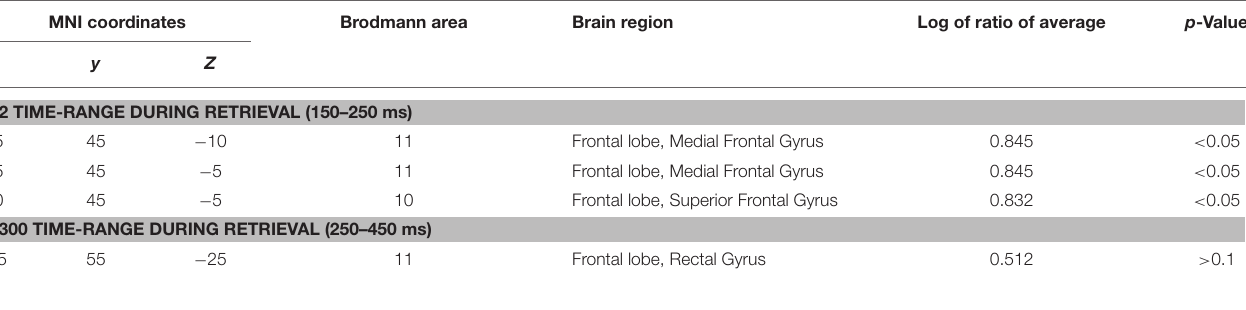
TABLE 4 | Comparison of aMCI and normal control group in sLORETA (voxels showing maximal difference). MNI coordinates Log of ratio of average